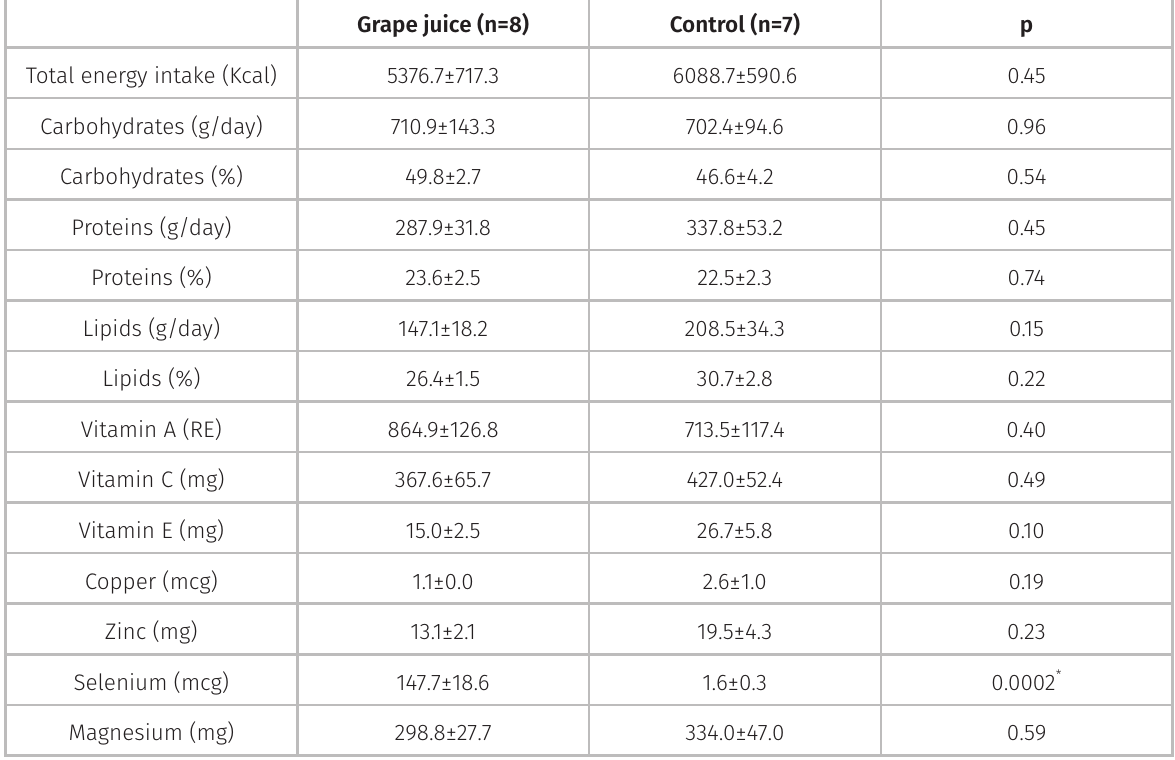
Table II. Food consumption of